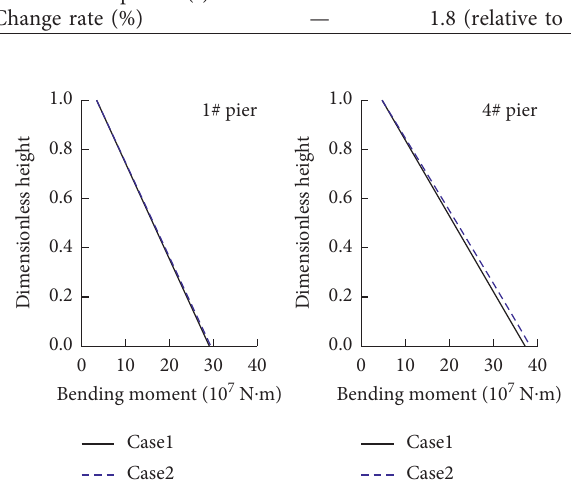
Figure 6: Bending moment envelopes of piers in Cases 1 and